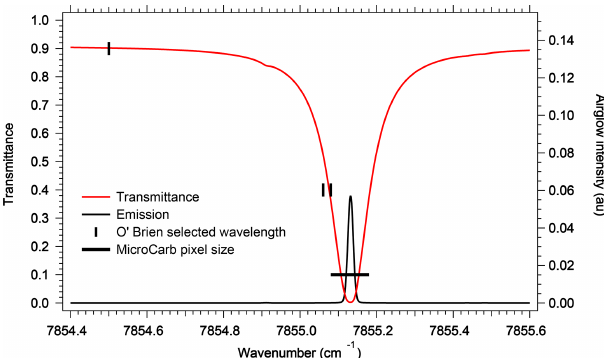
Figure 2. Comparison at high spectral resolution of spectral shape of atmospheric O 2 transmission (transmittance) and spectral shape of O 2 ∗ emission. The full width at half maximum (FWHM) of an individual O 2 line (red) is much wider than the FWHM of its coun- terpart in emission (black line), allowing in principle to disentan- gle absorption from emission at selected wavelengths. The channels recommended by O’Brien and Rayner (2002), of width 0.02cm − 1 , are represented: one outside an O 2 line for the continuum; the other two on the side of an absorption line but still outside the airglow emission line. The transmittance was calculated with HITRAN at nadir at highest spectral resolution. The black line represents the MicroCarb pixel size, giving a resolving power of